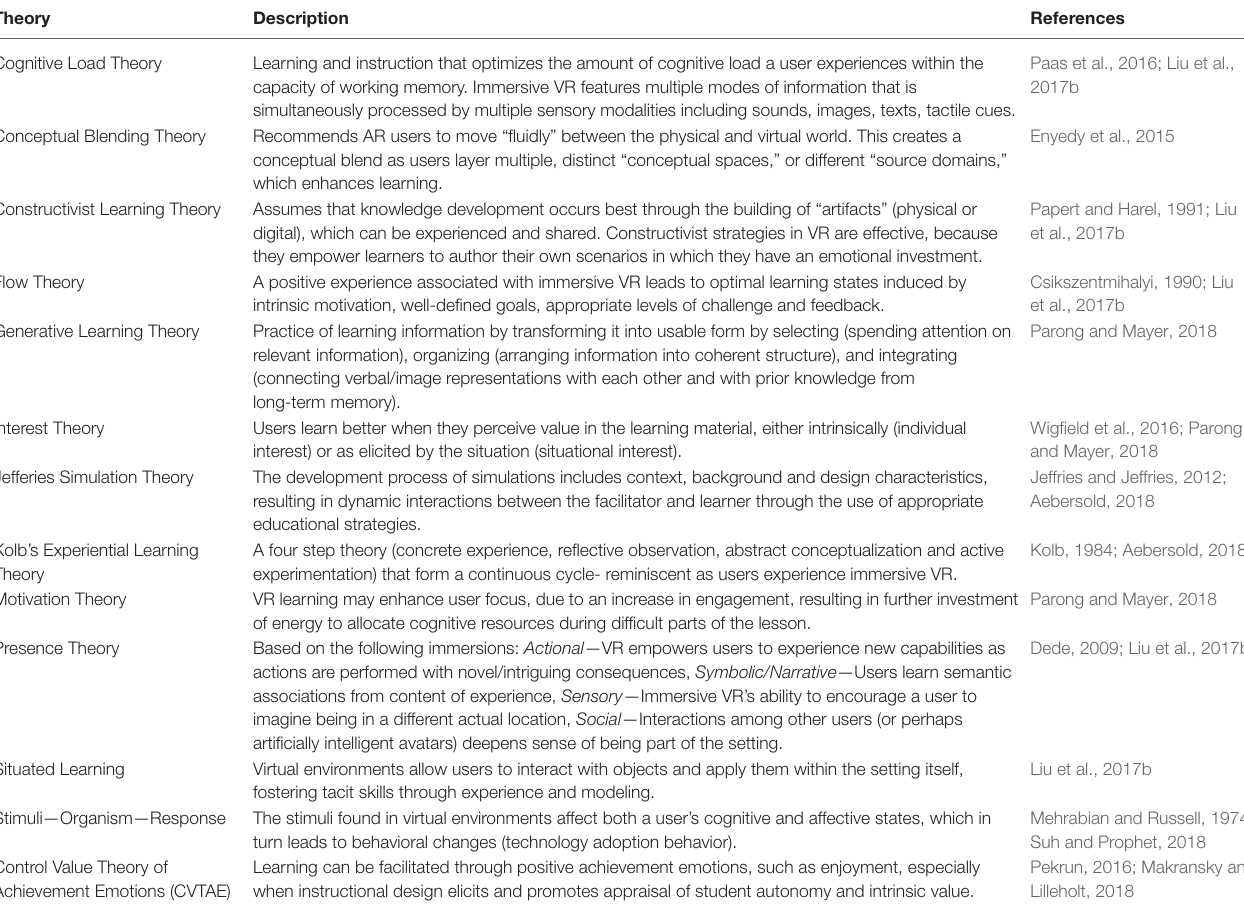
TABLE 6 | Summary of educational theories associated with immersive Virtual